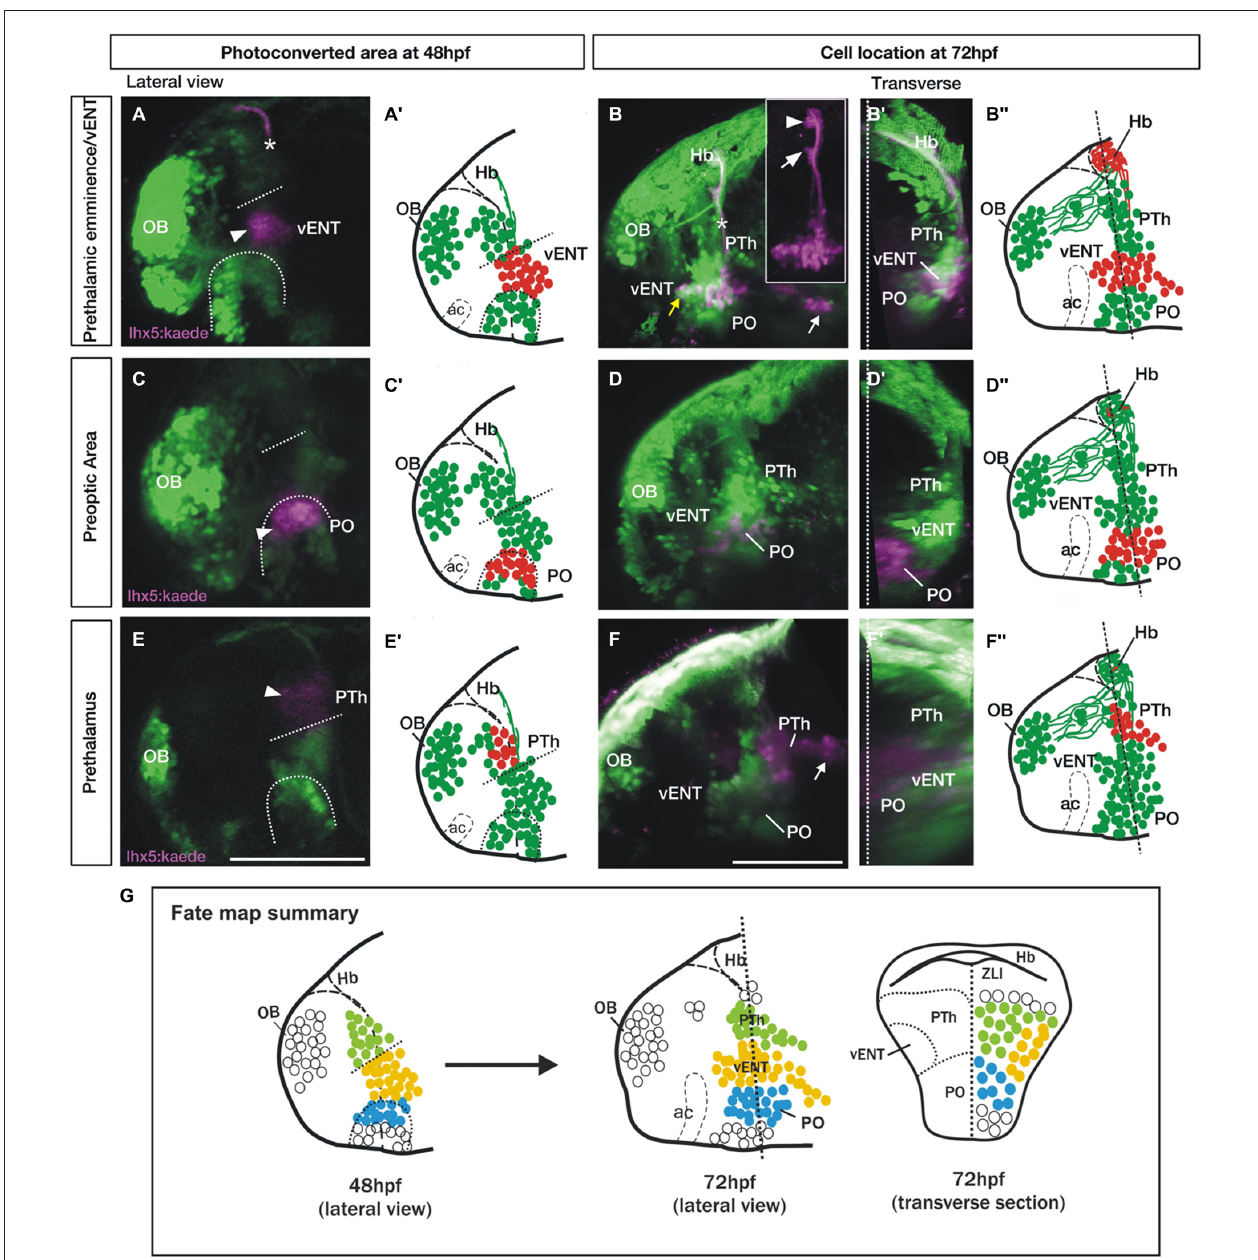
FIGURE 7 | Spatio-temporal fate map of the larval prethalamic eminence/prospective vENT and adjacent areas. Images and accompanying schematics show Kaede photoconversion areas in lateral views of 48 hpf Tg(lhx5:Kaede) b1204 fish (A,A (cid:48) ,C,C (cid:48) ,E,E (cid:48) ) and location of Kaede cells by 72 hpf in lateral view (B–B (cid:48)(cid:48) ,D–D (cid:48)(cid:48) ,F–F (cid:48)(cid:48) ) and transverse sections after 3D rendering (B (cid:48) ,D (cid:48) ,F (cid:48) ) . Dotted arch and lines at 48 hpf mark the dorsal limit of the preoptic area and prethalamic eminence respectively. Photoconversion in the prethalamic eminence ( n = 8). (A–B (cid:48)(cid:48) ) Cells were photoconverted from green to red (magenta in the images) at the diencephalic prethalamic eminence of Tg (lhx5:Kaede) b1204 embryos at 48 hpf (arrowhead in A , red cells in schematic A (cid:48)(cid:48) ) and their location was then imaged by 72 hpf in lateral view ( B and red cells in B (cid:48)(cid:48) ). Note in (A) that area of photoconversion by 48 hpf is located at the level of the tract of the habenular commissure (marked with a star). (B (cid:48) ) is transverse section after 3D rendering. Note that 24 h after photoconversion, red Kaede expressing neurons have expanded from the photoconversion area rostrally into the telencephalon (yellow arrow) and caudally into hypothalamic areas (white arrow). These red Kaede cells send afferent projections to ventral (arrow in B inset) and dorsal halves (arrowhead in B inset) of the habenula and were identified as vENT. Transverse section shows that the vENT occupies a lateral position within the forebrain (B (cid:48) ) . Photoconversion in preoptic regions (PO) ( n = 9) . (C–D (cid:48)(cid:48) ) Cells were photoconverted in the presumed preoptic area of Tg (lhx5:Kaede) b1204 embryos at 48 hpf (C,C (cid:48) ) . Note that 24 h after photoconversion, most red Kaede cells maintain their relative rostro-caudal positions within the telencephalon and diencephalon (D) , and are located ventro-medially relative to the vENT when viewed in transverse section (D (cid:48) ) . Most conversions of presumptive PO ( n = 6/9) did not result in labeling of habenula afferents. Photoconversion of the prethalamus (PTh; n = 3) . (E–F (cid:48)(cid:48) ) Cells were photoconverted in the